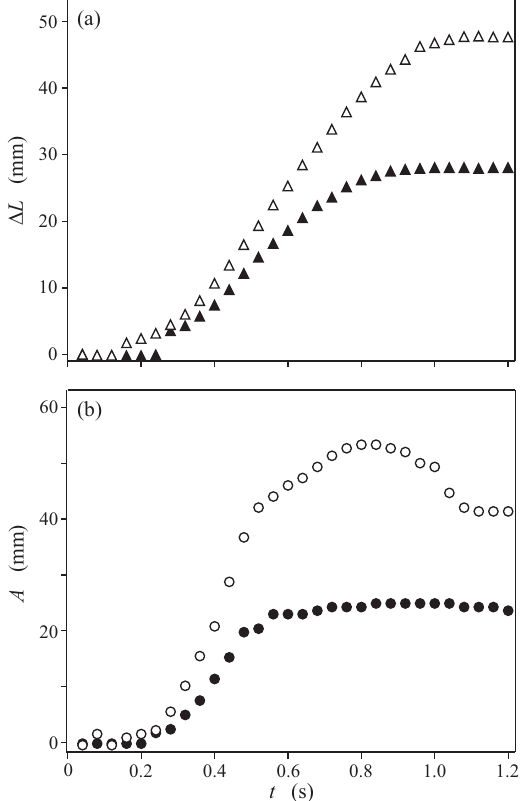
Figure 4. Time evolution of (a) the runout length Δ L and (b) the amplitude A of leading wave, for the ( (cid:2) , • ) non-breaking and ( (cid:5) , ◦ ) breaking waves presented in Figs. 2 and 3